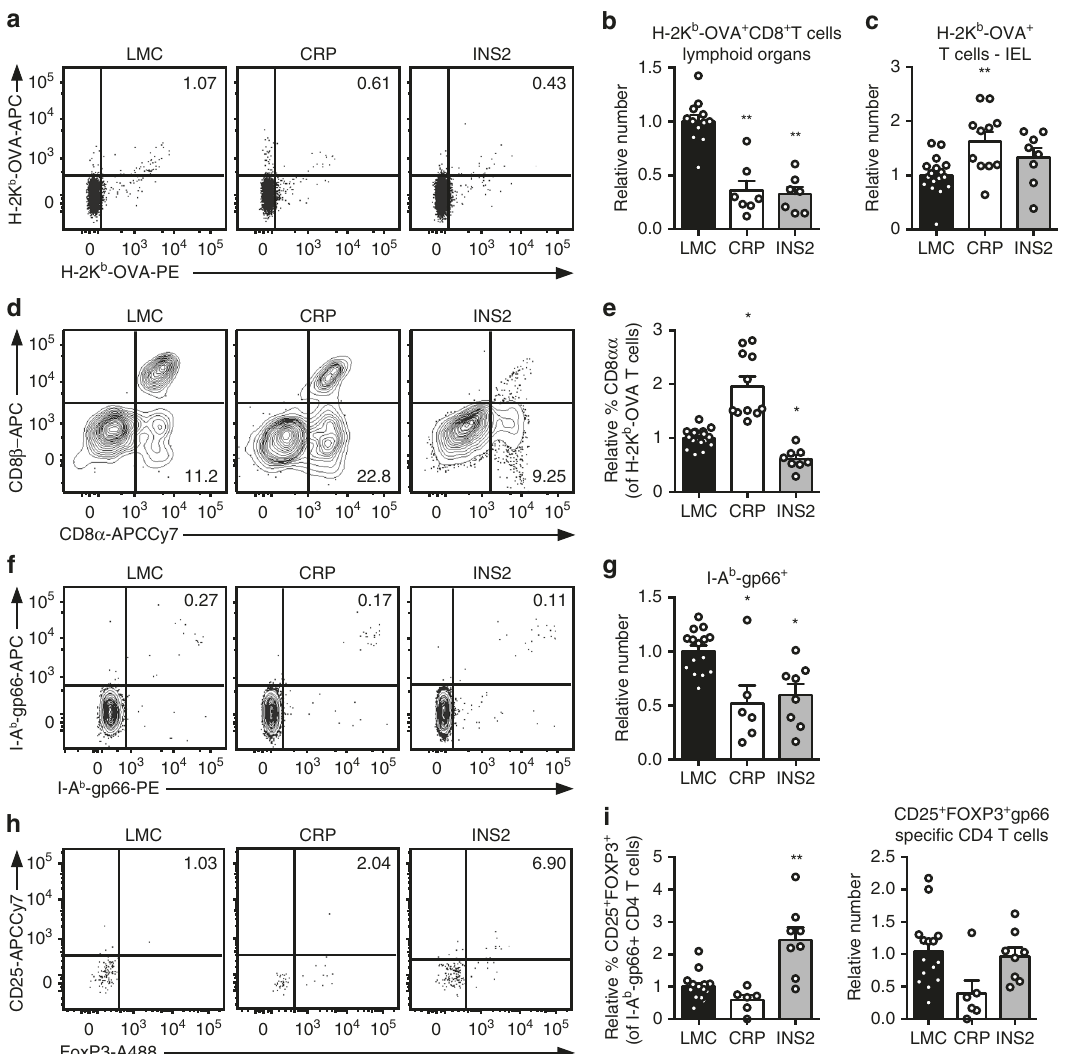
Fig. 5 TRA expression by distinct mTEC compartments impacts the mode of tolerance induction in the polyclonal T cell repertoire in naïve mice. a Representative fl ow plots of H-2K b -OVA tetramer on pooled peripheral lymph nodes and spleen cells from naïve mice after enrichment, gated on live TCR αβ + CD8 + T cells. Relative number of H-2K b -OVA-speci fi c TCR αβ + CD8 + T cells in the peripheral secondary lymphoid organs (mean± SEM, n = 12 LMC, 7 CRP, 7 INS2) ( b ) and intraepithelial lymphocytes (IEL) (mean ± SEM, n = 17 LMC, 11 CRP, 8 INS2) ( c ) from CRP and INS2 Tg mice as compared to their respective littermate controls (LMC). d Representative fl ow plot of CD8 α and CD8 β and e relative proportion of TCR αβ + CD8 αα within the H-2K b - OVA tetramer double positive TCR αβ IEL of CRP and INS2 Tg mice as compared to their respective LMC (mean ± SEM, n = 17 LMC, 11 CRP, 8 INS2). f Representative fl ow plots of I-A b -gp66 tetramer on pooled peripheral lymph nodes and spleen cells from naïve mice, gated on live TCR αβ + CD4 + T cells. g Relative number of I-A b -gp66 tetramer DP CD4 + T cells in the peripheral lymph nodes and the spleen of naïve mice. h Representative fl ow plots of CD25 and FoxP3, gated on live I-A b -gp66 tetramer + CD4 + T cells. i Relative proportion of CD25 + FoxP3 + T reg of gp66-speci fi c CD4 + T cells and relative number of gp66-speci fi c CD4 + CD25 + FoxP3 + T reg from CRP and INS2 peripheral lymph nodes and spleen as compared to their respective LMC. Absolute numbers were normalized to LMC for each Tg line and in each experiment for the relative number calculation ( g and i , mean ± SEM, n = 15 LMC, 6 CRP, 8 INS2). Data are pooled from at least two independent experiments. All the p values indicated are calculated by Kruskal – Wallis test followed by Dunn ’ s post-hoc comparisons to LMC. * p < 0.05, ** p < 0.01 relative to LMC. Source data are provided as a Source Data fi